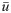
Near bottom speed and zonal velocity.(a) mean speed; (b) maximum speed; (c) mean zonal velocity u¯; (d) maximum zonal velocity uMAX at the model bottom layer. Unit: ms-1. Black dots mark the coral locations. Bathymetric isolines as in Fig 1.